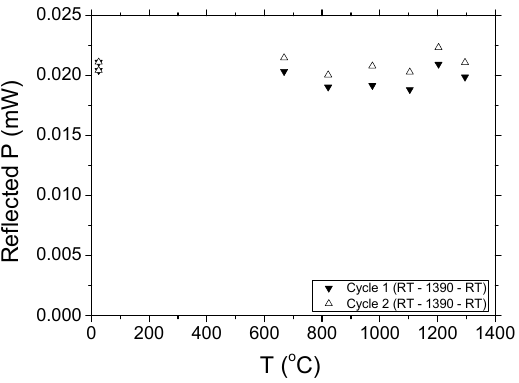
Figure 2. Measured reflected power during high temperature cycling two times (room temperature to 1295 o C).